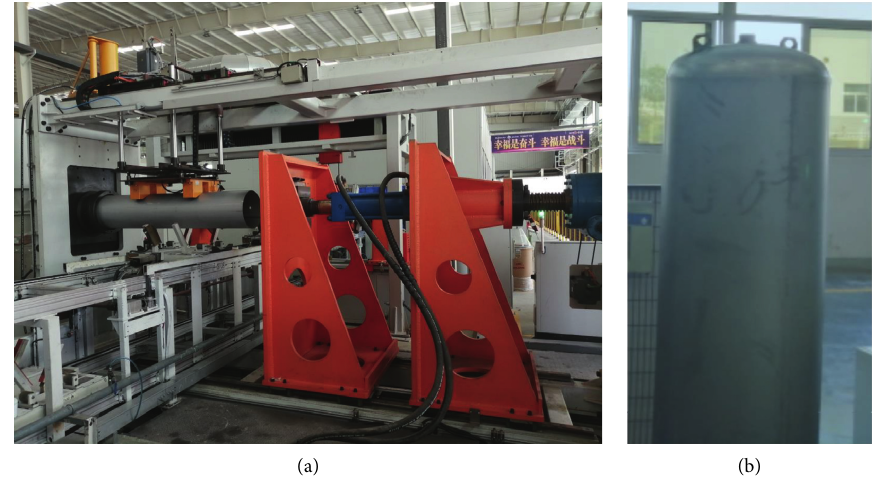
Figure 17: The water heater tank capping